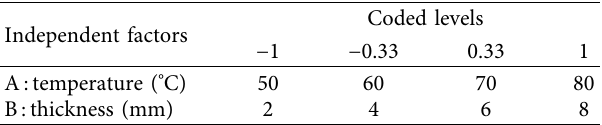
Table 1: Experimental independent factors and levels used in tray drying of